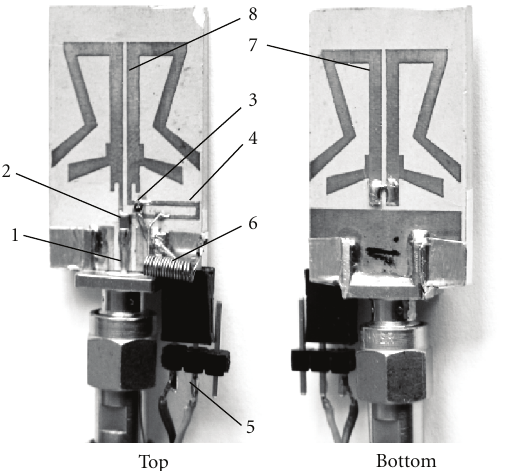
Figure 10: Picture of the PIN diode antenna, top and bottom.